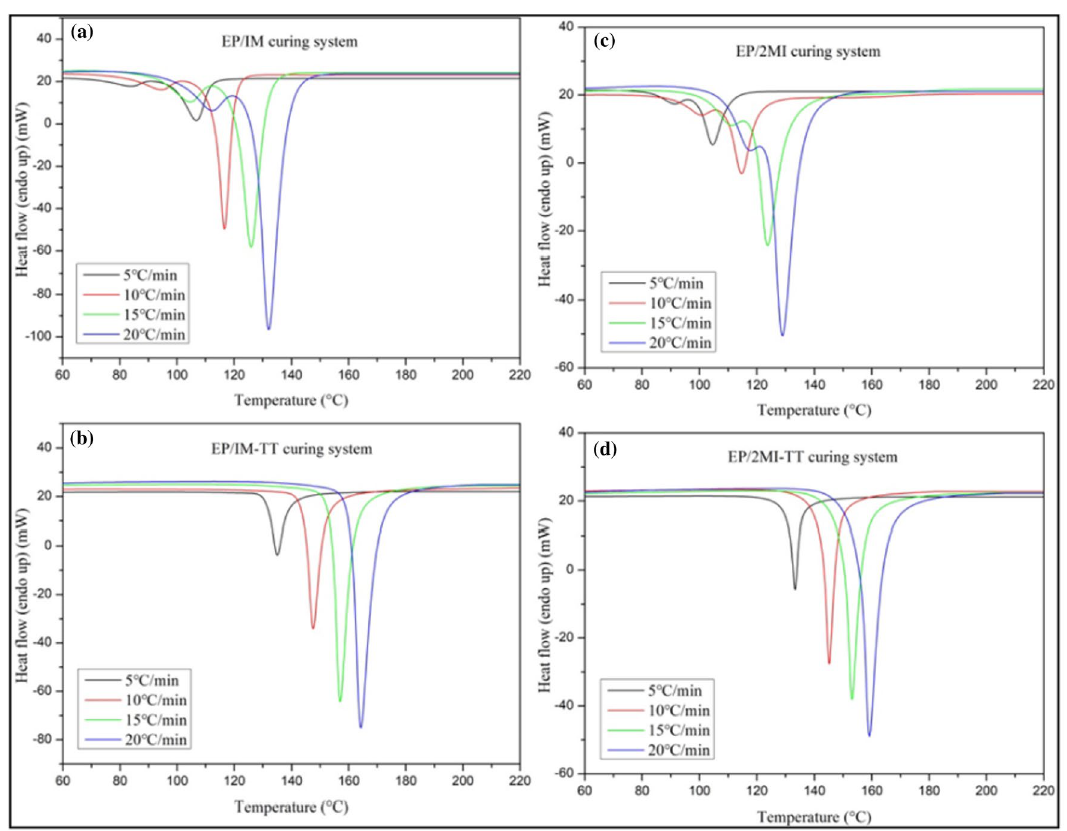
Fig. 6 DSC curves of the EP blends tested with the heating rate of 5, 10, 15, and 20 °C/min for IM, 2MI, IM-TT and